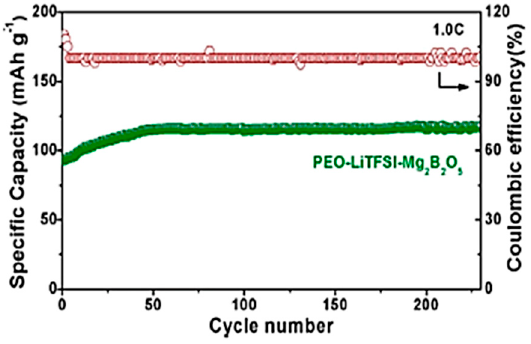
Figure 19. Cycling performance of LiFePO 4 /Li solid-state Li-ion batteries with poly(ethylene oxide)/LiTFSi/10% Mg 2 B 2 O 5 at 50 ◦ C [59], © 2018.